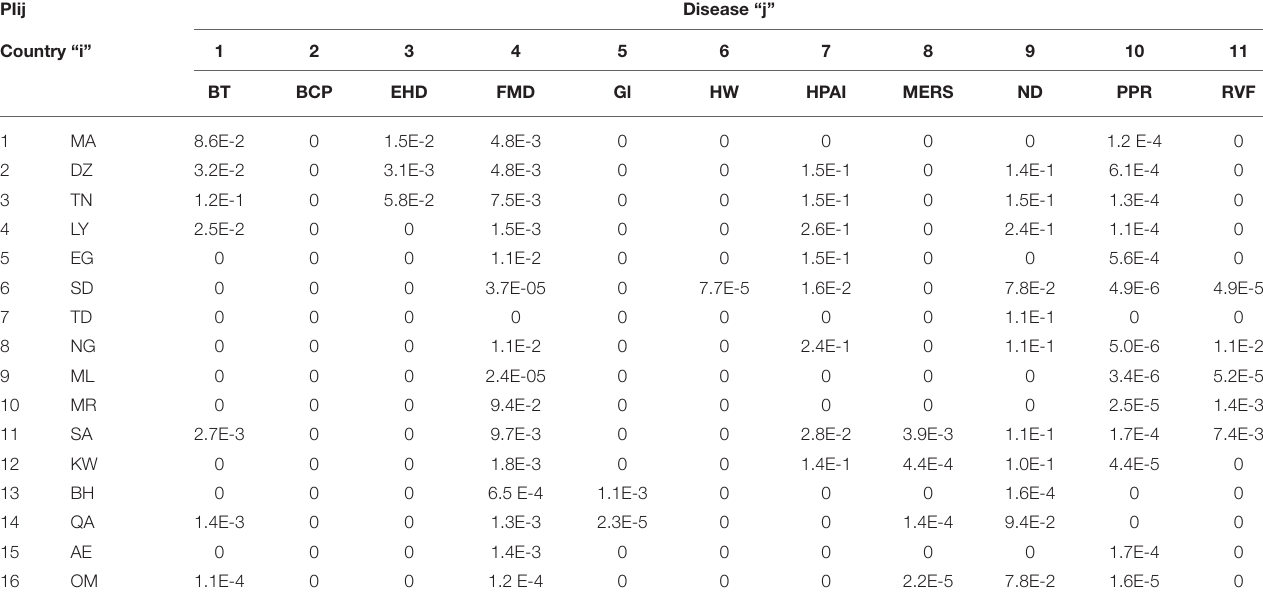
TABLE 10 | Total probability of entry of the j disease from the country i to the European Union. PIij Disease